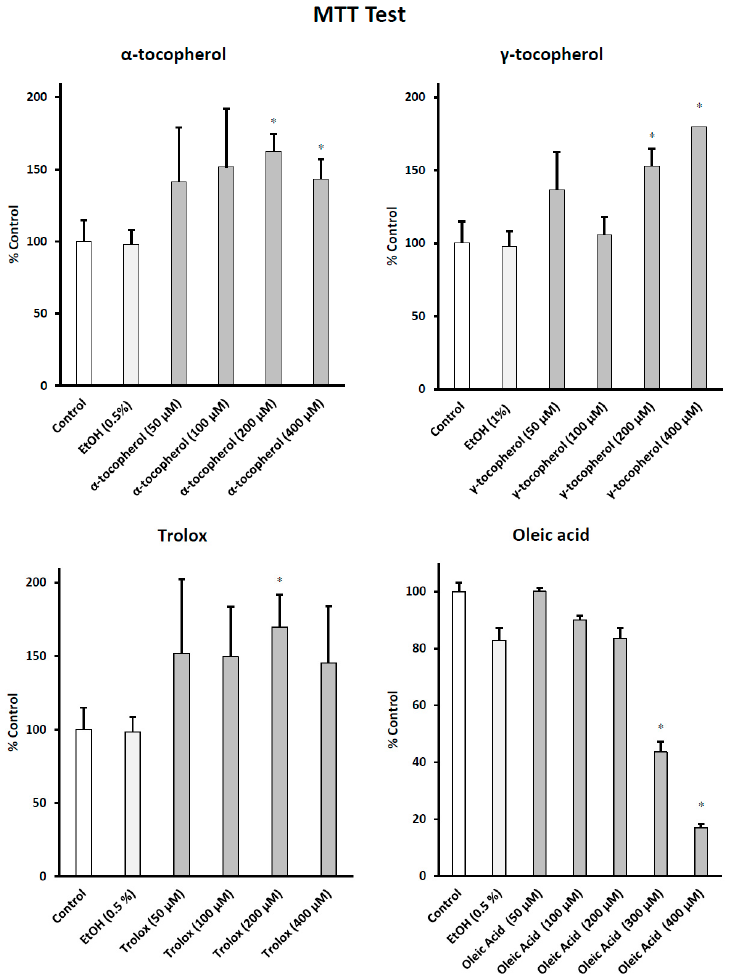
Figure 1. Effects of α -tocopherol, and γ -tocopherol, Trolox, and oleic acid on mitochondrial activity and/or cell growth. Murine microglial BV-2 cells were cultured for 24 h in the presence of α -, and γ -tocopherol, Trolox and oleic acid (OA) (50–400 µM) and the effect on mitochondrial activity and/or cell growth was determined with the MTT test. No difference was observed between control and vehicle (EtOH 0.5%–1%)-treated cells. The EtOH values correspond to the highest EtOH concentrations added to the culture medium: 0.5% with α -tocopherol, Trolox, and OA; and 1% with γ -tocopherol. Differences between vehicle and treated cells (* means significant differences by Mann–Whitney test; p ≤ 0.05). Data are mean ± SD of three independent experiments.